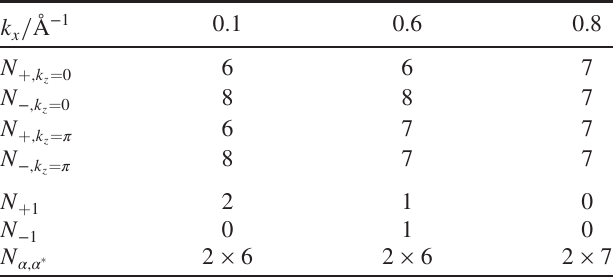
TABLE I. Multiplicity N of the positive and negative (cid:3) ;k z ¯ M branches of the z eigenvalues in the two mirror-invariant planes k z ¼ 0 ; π for three selected k x at constant k y ¼ 0 . 04 Å − 1 . In addition, we list the number N of Wilson-loop eigenvalues (cid:3) 1 quantized to (cid:3) 1 and number N α ; α (cid:4) of complex-conjugate pairs α ; α (cid:4) obtained by the mapping discussed in the Appendix at each k k point, 14 bands are x . At each